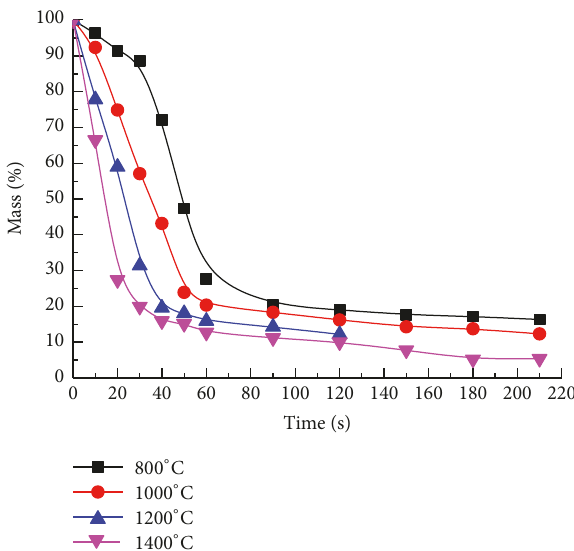
Figure 3: Mass loss curves of wood pellet combustion.